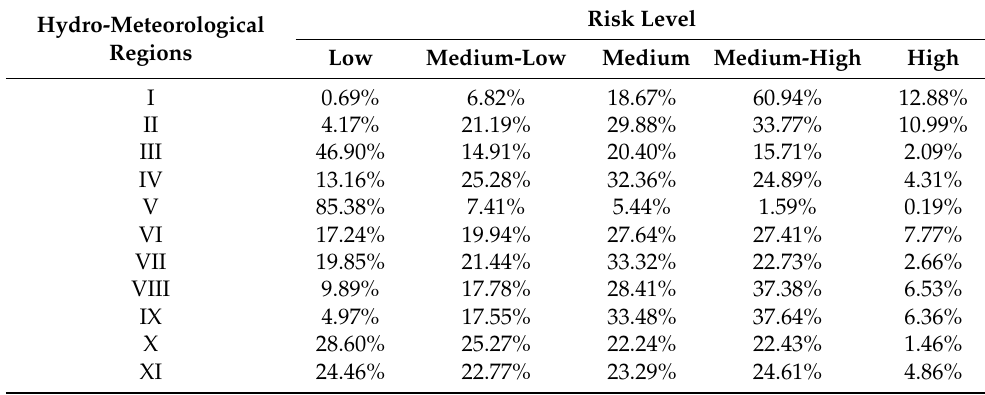
Table 15. The Proportion of Risk Areas of Different Levels in Hydro-meteorological